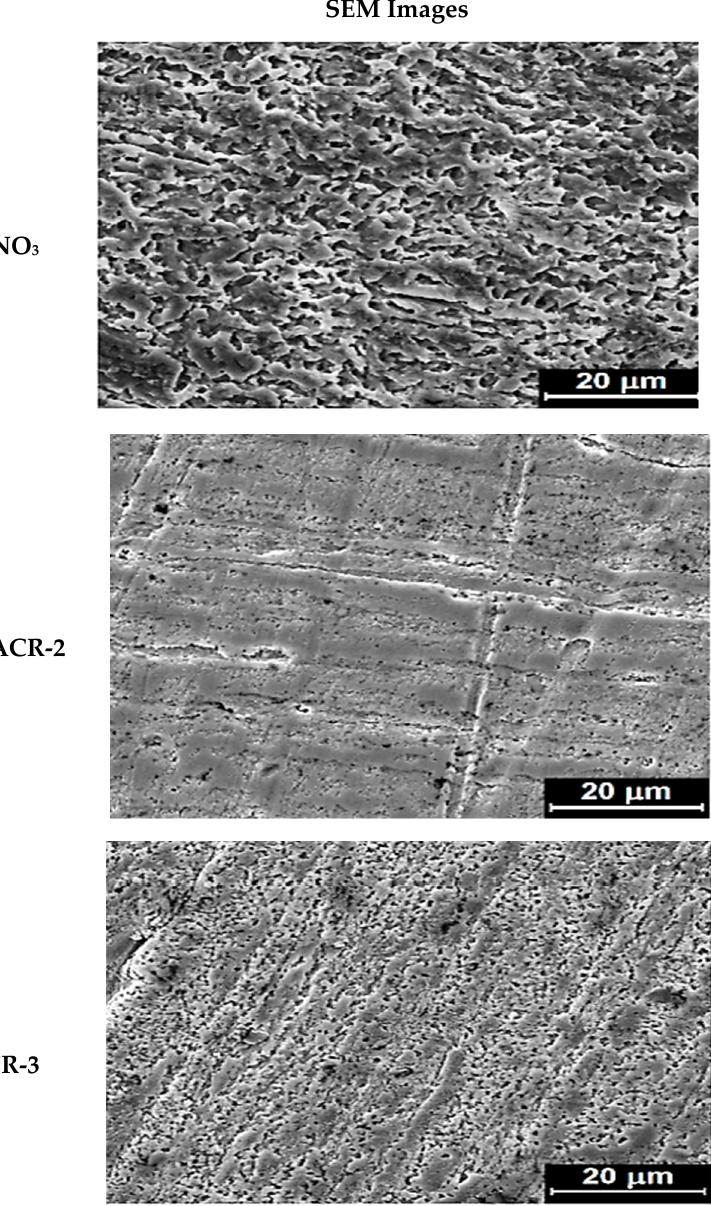
Figure 18. SEM images from Cu ( a ) after soaking time for 5 h in 1.0 M HNO 3 , and ( b ) in the 20 × 10 − 5